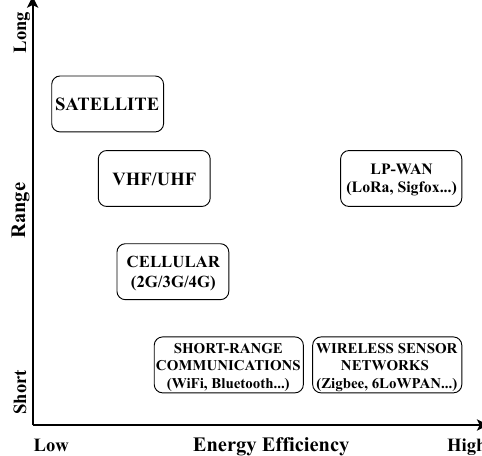
Figure 1. Comparison of transmission range and energy efficiency provided by different communication technologies employed in maritime